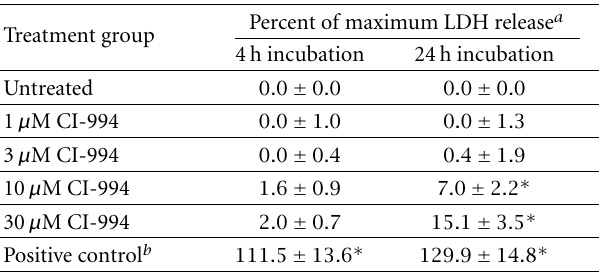
Table 1:LDHreleasefromratperipheralbloodlymphocytestreated with CI-994.